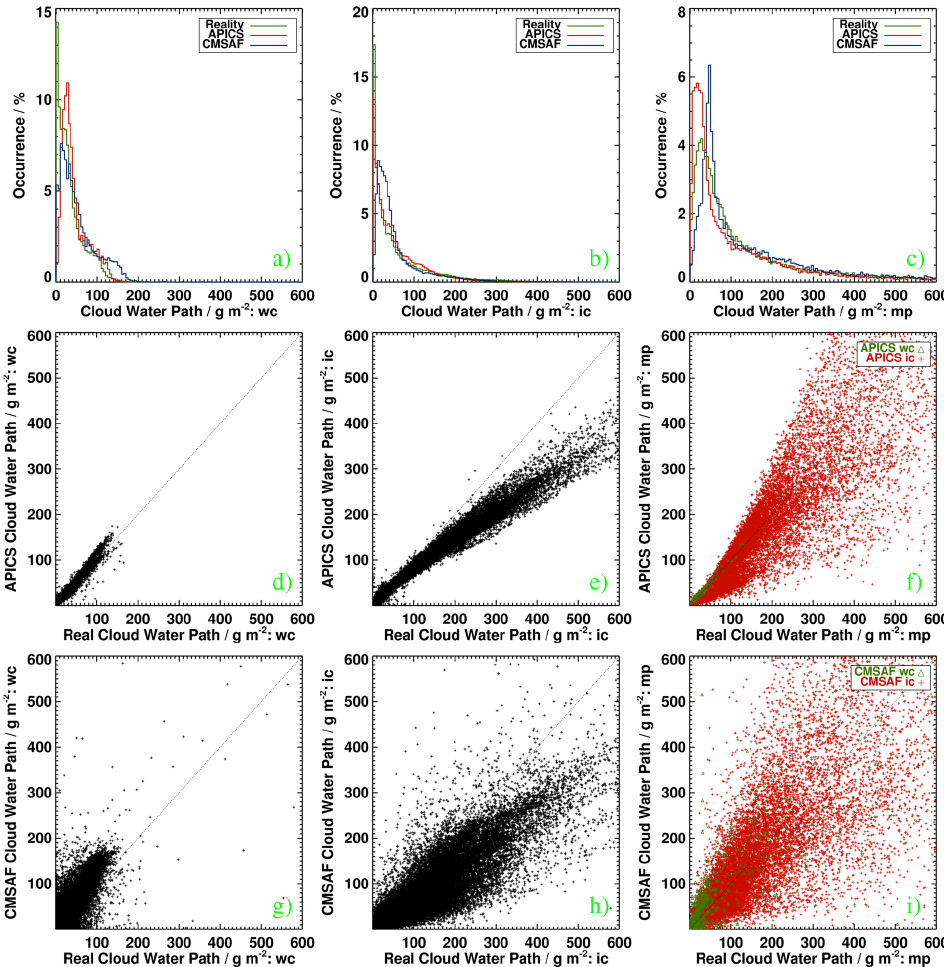
Fig. 13. Histograms and scatter plots of retrieved and real cloud water path for both APICS and CMSAF. (a–c) Histograms of retrieved and real cloud water path of water, ice and multi-phase clouds for both APICS and CMSAF. (d–f) Scatter plots of APICS cloud water path against real cloud water path for water, ice and multi-phase clouds. (g–i) Scatter plots of CMSAF cloud water path against real cloud water path for water, ice and multi-phase